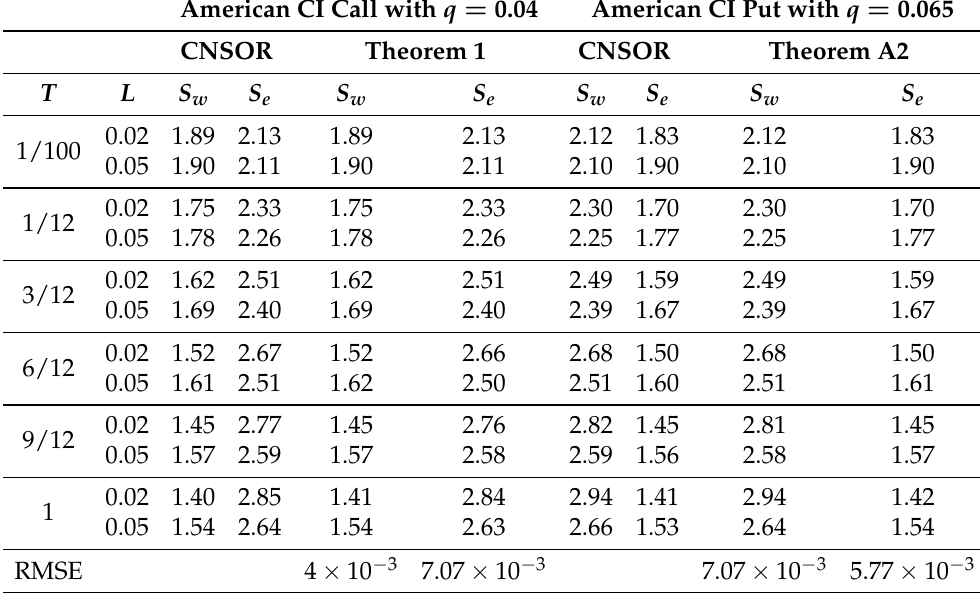
Table 4. Comparison of optimal exercise S e prices and exit/withdraw S w prices for American CI call and put options with X = 2, r = 0.05, σ =